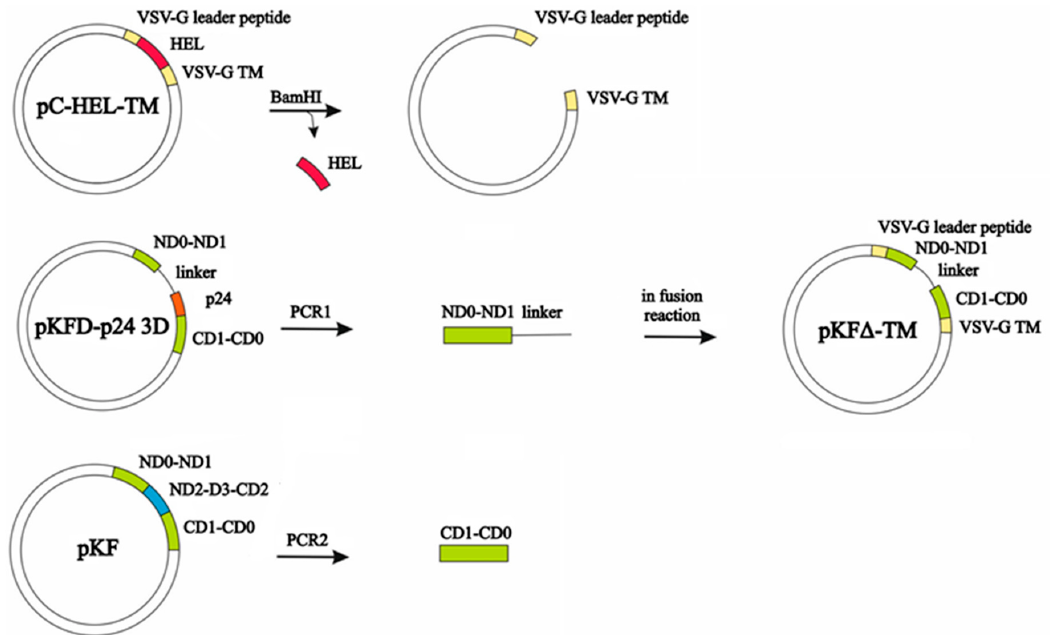
Figure A1. Cloning strategy for the generation of the pKF Δ -TM expression plasmid. The pKF ∆ -TM